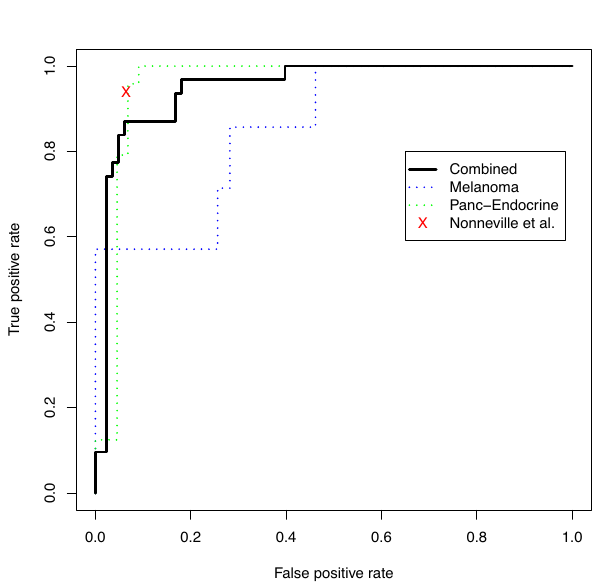
Fig. 1 Receiver operating characteristic analysis. The curve shows the True positive rate (sensitivity) and the Fales positive rate (1 – speci fi city) for all possible thresholds on the ALT probability score (Sieverling et al. 1 ).